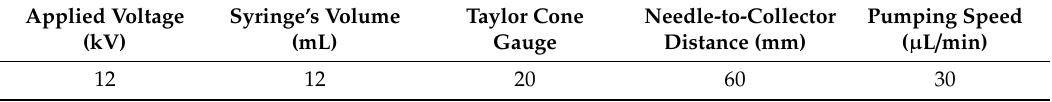
Table 3. Input factors of the electrospinning process.